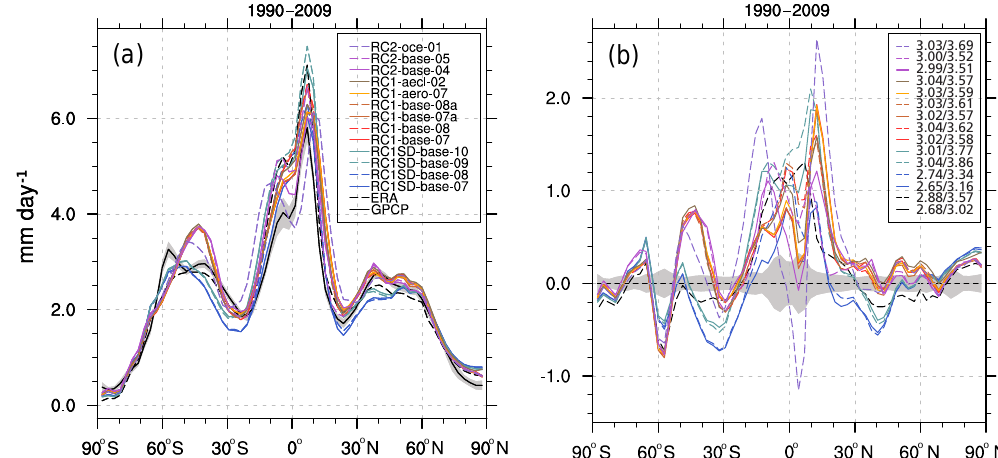
Figure 13. (a) Zonal distribution of mean precipitation (mmday − 1 ) for the time period 1990–2009 for all simulations covering this period plus GPCP and ERA-Interim. (b) Deviation of the simulated zonal distribution of precipitation (mmday − 1 ) shown as simulation results minus GPCP and ERA-Interim minus GPCP. Colour-coding as in panel (a) . Shading in both panels (a) and (b) is ± 1 σ of the annual variation in GPCP data (1990–2009). The numbers in panel (b) list the corresponding global and tropical (30 ◦ S–30 ◦ N) average precipitation (in mmday − 1 ),